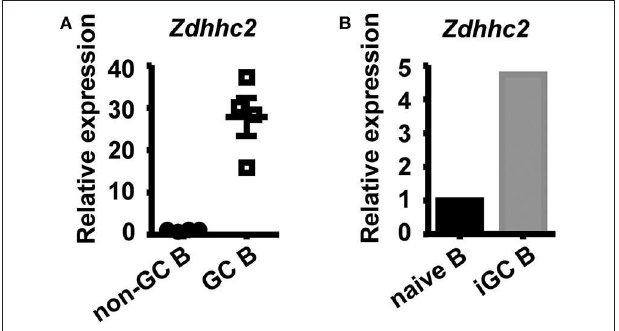
FIGURE 5 | High expression levels of Zdhhc2 in germinal center (GC) B cells. (A,B) Graphs showing the relative Zdhhc2 mRNA levels, quantified by qRT-PCR, in non-GC B and GC B cells sorted by fluorescence-activated cell sorting (FACS) from Peyer’s patches of wild-type mice (A) , FACS-sorted splenic naïve B cells, and induced GC B cells (iGC B) cultured as in Figure 4A . Each symbol in (A) represents the sample from an individual mouse. N = 1 in (B)